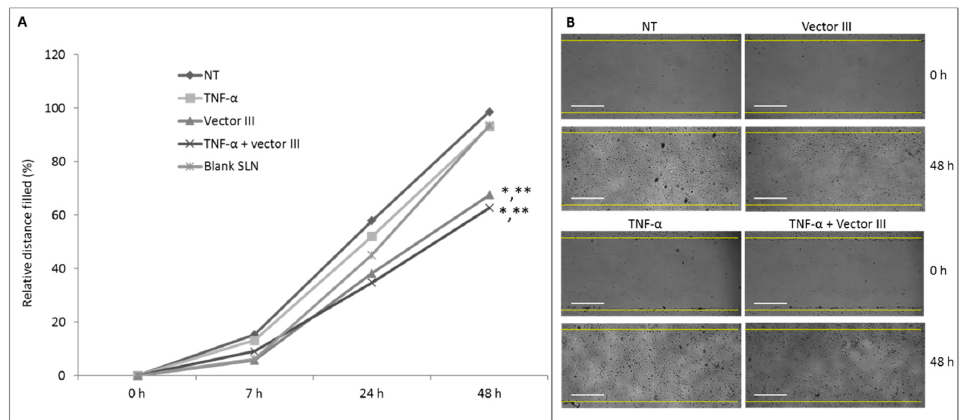
Figure 7. The fluorescence microscopy images of HCE-2 cells at different times after addition of vector